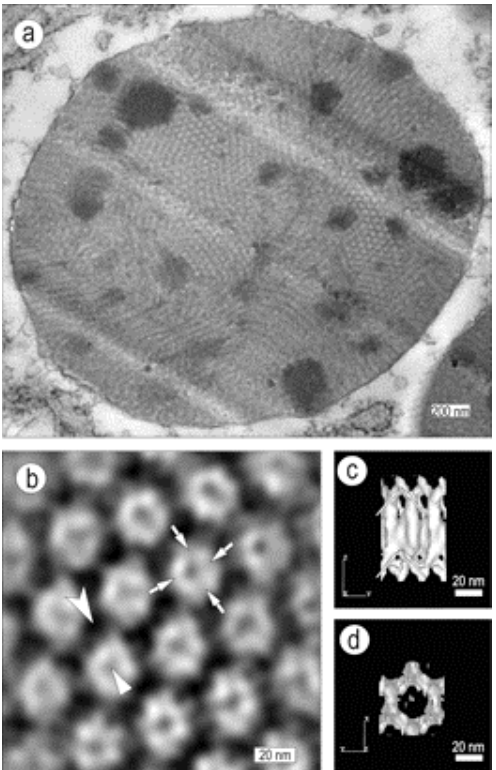
FIGURE 7. Hexagonal columnar liquid crystals made of dogfish egg case collagen. (a) Typical view of a storage granule. (b) Fourier-filtered image of a transverse view. The corner of each hexagon appears relatively dense and massive (chevron); a lower protein density is seen in the centre of each hexagon (arrowhead). Spikes of protein density irradiate irregularly from the centre of each hexagon (arrows). (c) Longitudinal view of the three-dimensional reconstruction of the hexagonal columnar collagen arrangement. Protein strands show a preferred molecular direction of about 40 to 50 o to the long axis. (d) Transverse view. Axial columns of protein density lie on the vertices of hexagonal cells and are connected by irregular sheets of